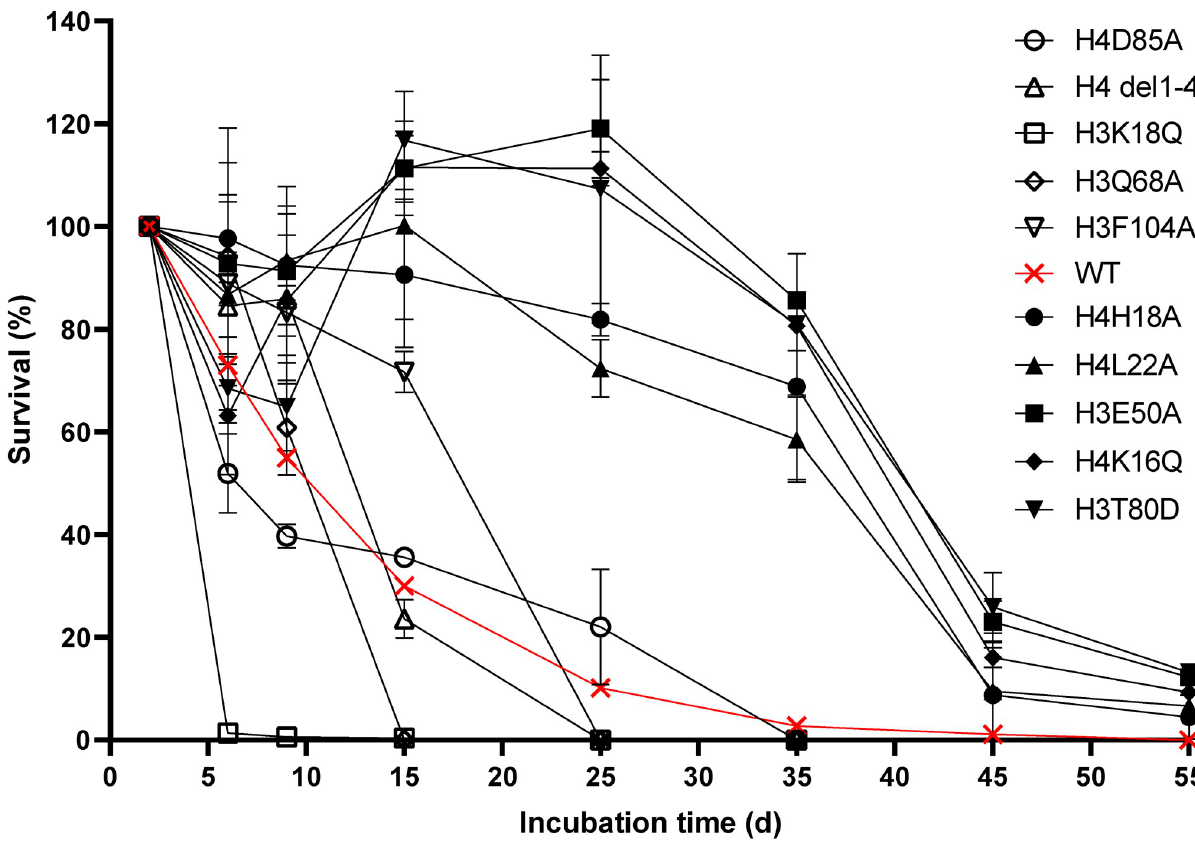
Fig 2. Growth curve of selected strains with extended and truncated lifespans. Strains with extended or shortened lifespans were selected and cultured individually for up to 55 days. The cell density of each strain was determined at different times, and the percentage cells remaining relative to the starting culture is shown at the different culture times. The strain with the WT histones H3 and H4 are indicated by the red plot. Experiments were performed in duplicate. Error bars show the standard deviation